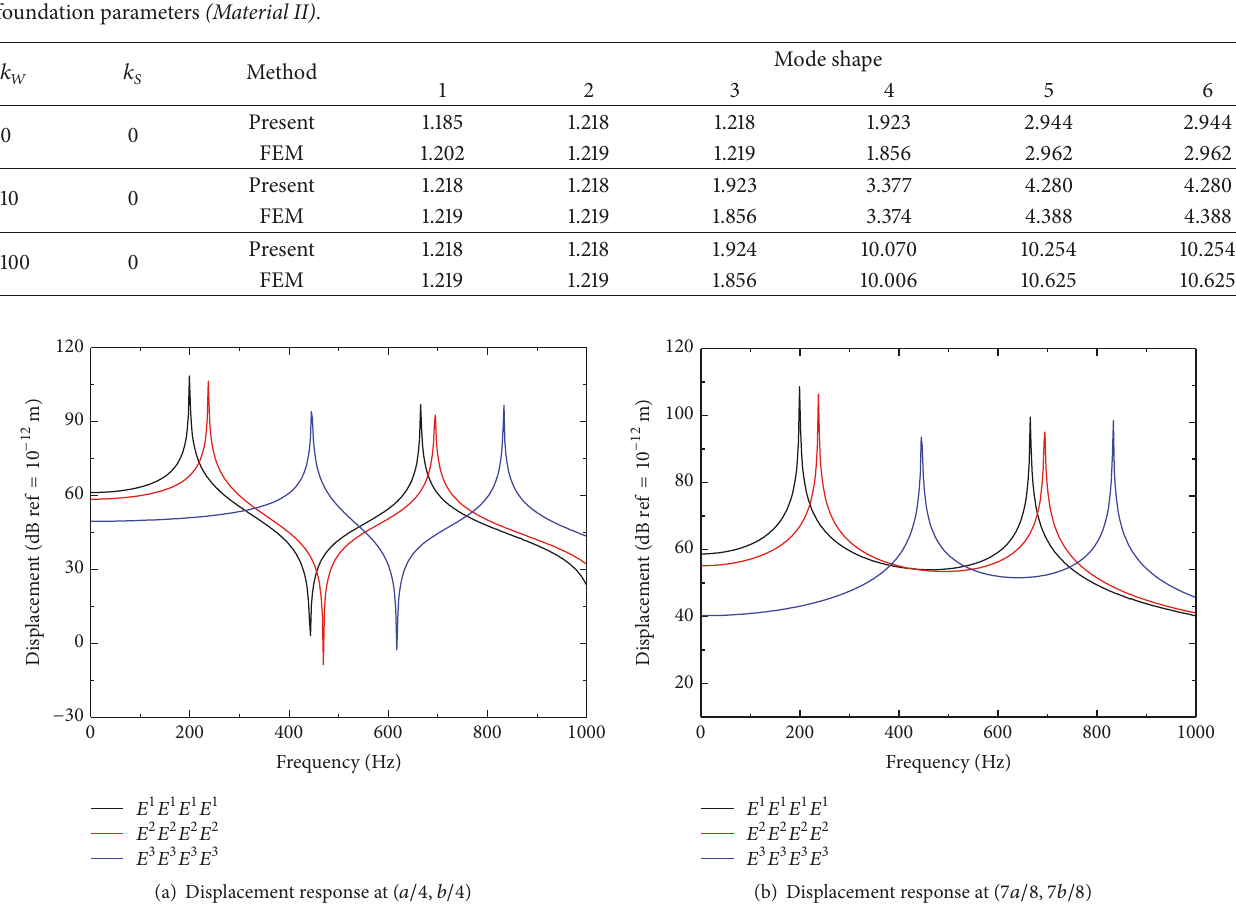
Figure 6: Vibration displacement response of the laminated foundation plate with various elastic